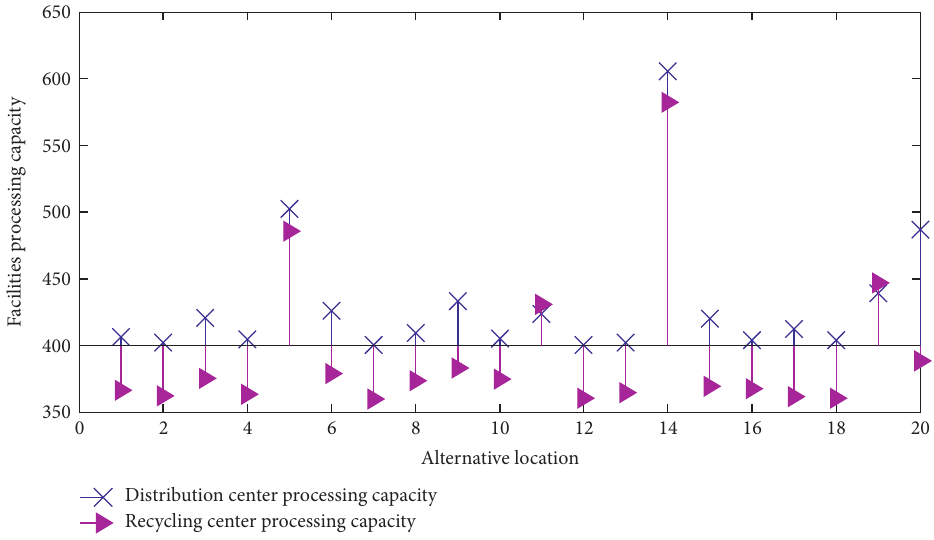
Figure 7: Processing capacity of various types of logistics facilities at alternative locations.